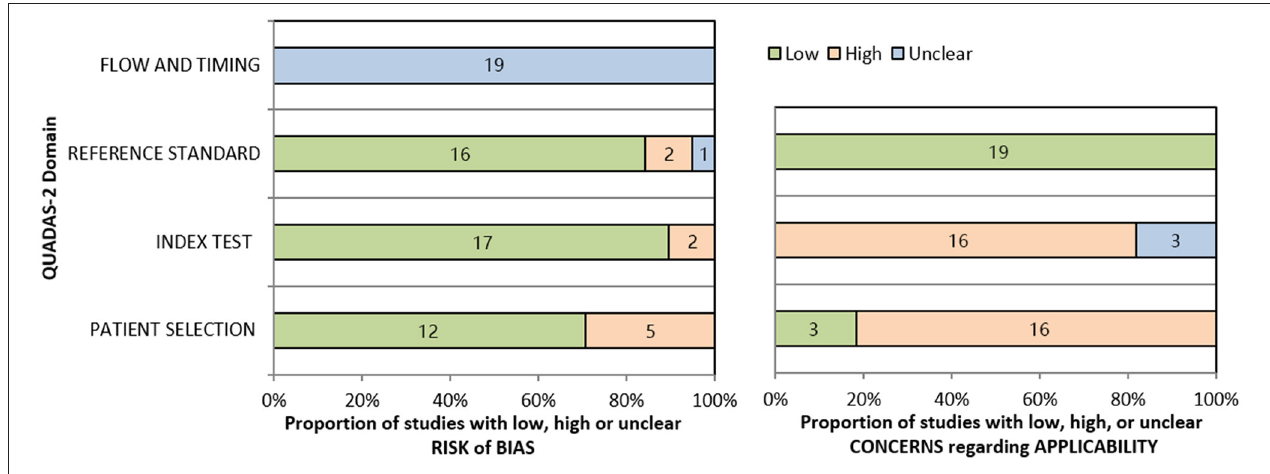
FIGURE 3 | Summary of QUADAS-2 assessments of included studies.